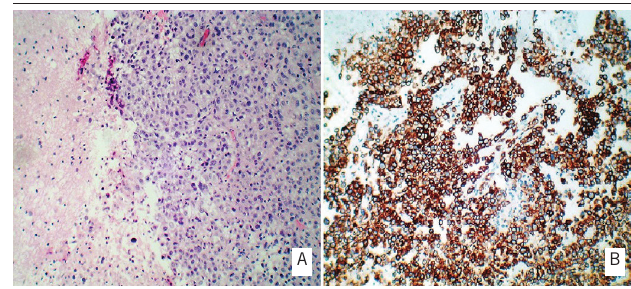
taBLE 2 – Association of breast invasive ductal carcinoma with brain metastases: comparison between groups regarding hormone and c-erb-B2 receptors Variables